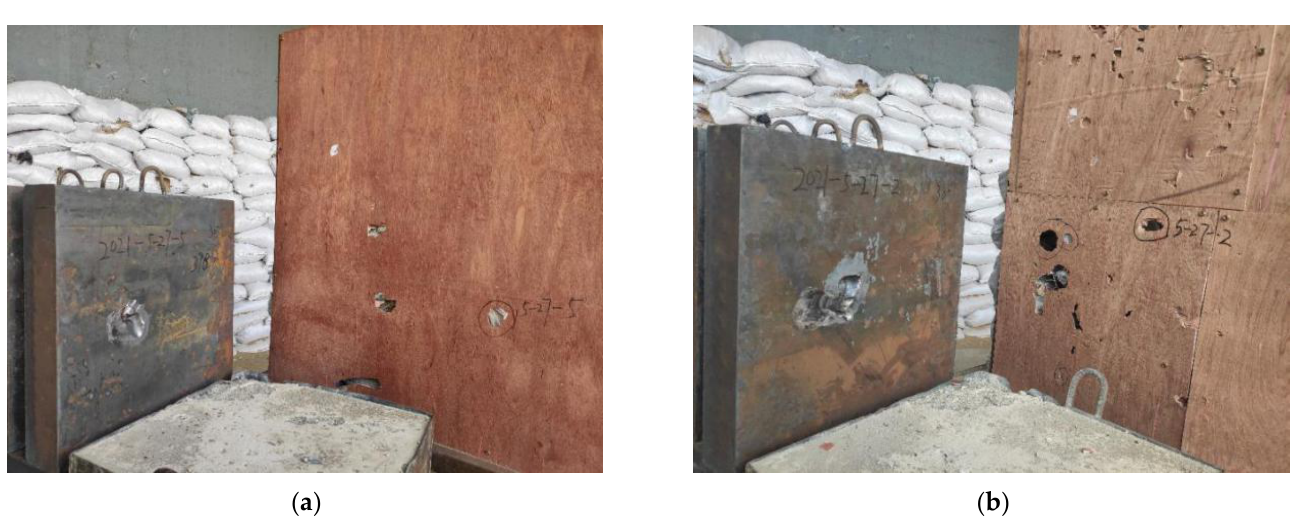
Figure 11. Experimental results of the ricocheting projectile: ( a ) 398 m/s, 30° obliquity; ( b ) 411 m/s, 30° obliquity.